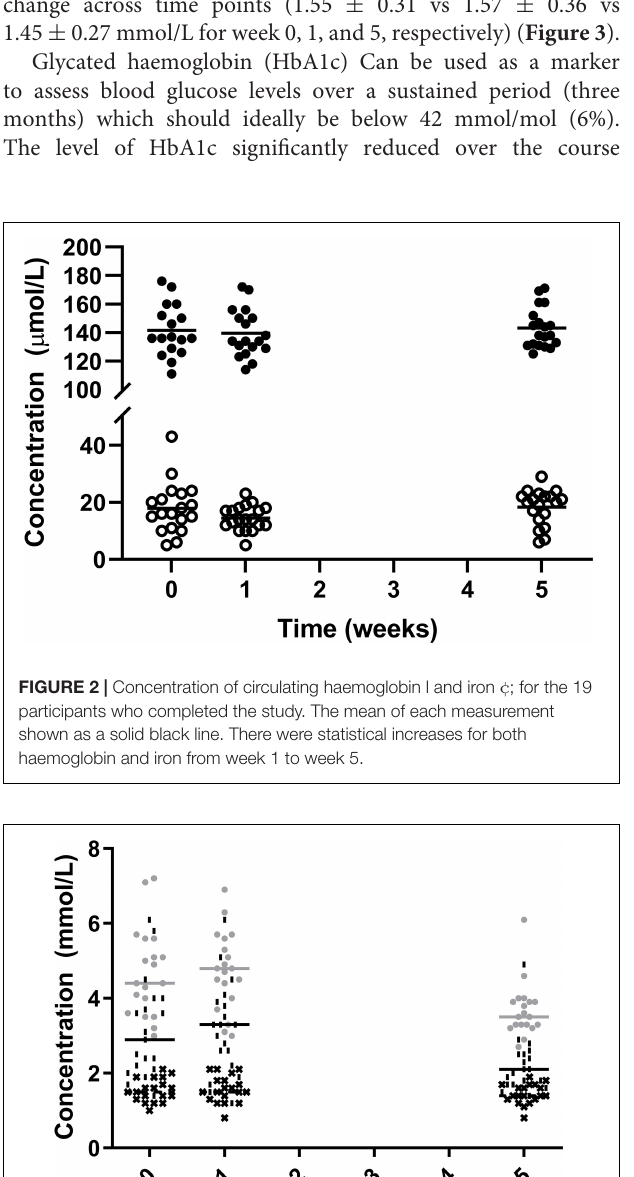
FIGURE 3 | Total Cholesterol ( • ), Non-HDL Cholesterol ( | ), HDL cholesterol ( (cid:54) ), for the 19 participants who completed the study. The mean of each measurement shown as a solid grey line for total cholesterol and a solid black line for non-HDL cholesterol and HDL